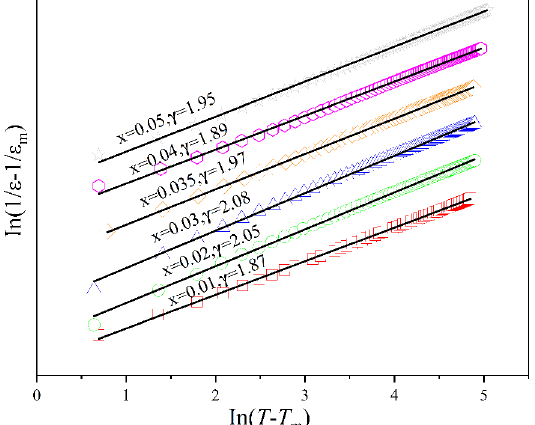
Figure 8. Plot of ln(1/ε-1/ε m) versus ln( T - T